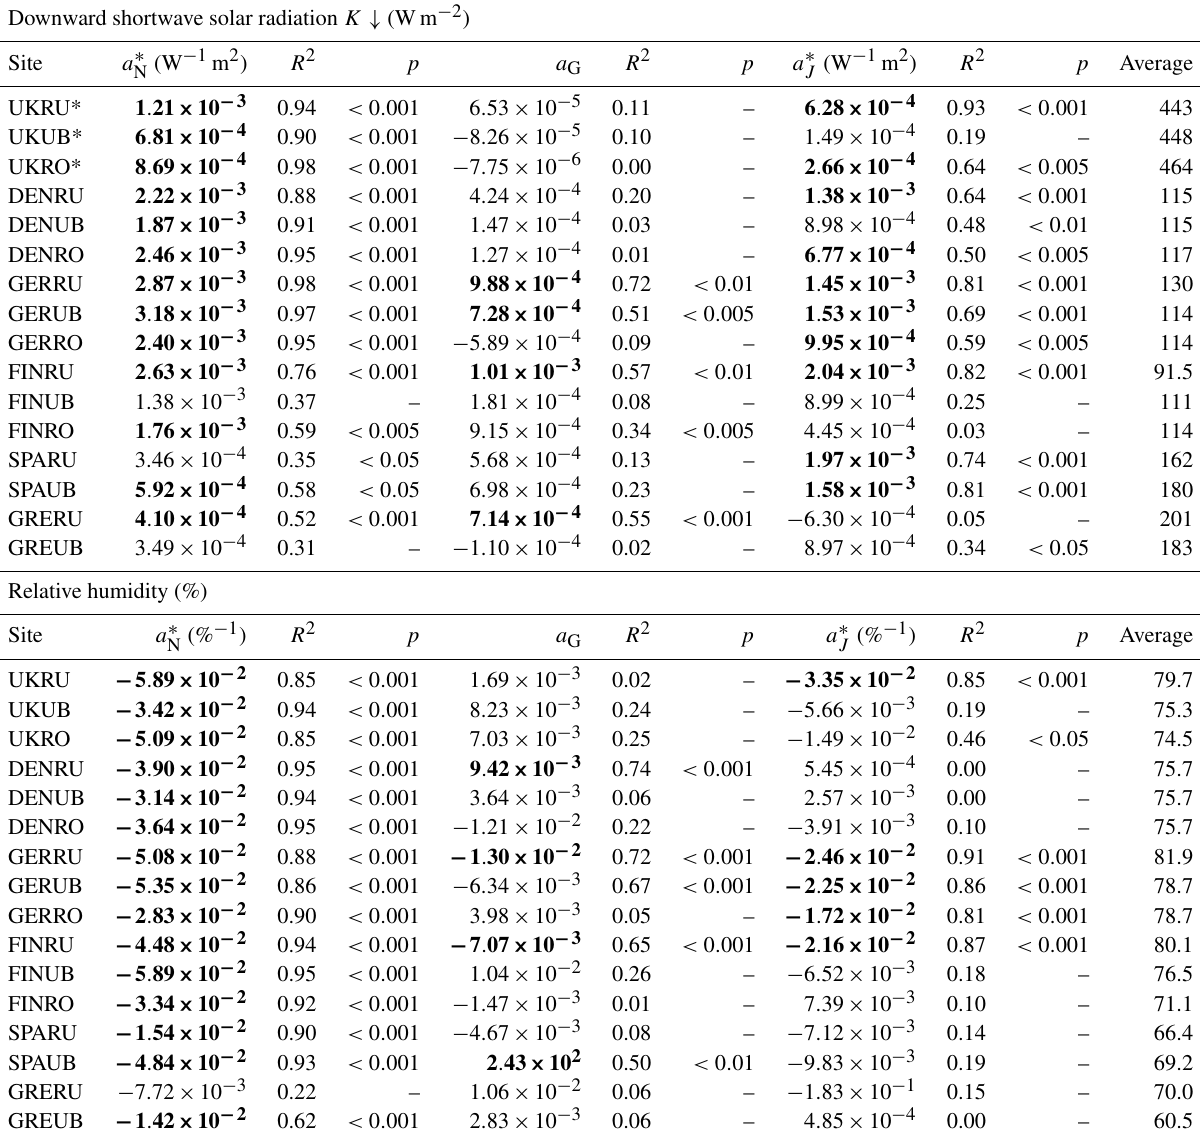
Table 3. Normalised gradients (non-normalised for growth rate), R 2 , and p values (– for values > 0 . 05) for the relation between meteoro- logical conditions and NPF event variables. Gradients of R 2 > 0 . 50 are in